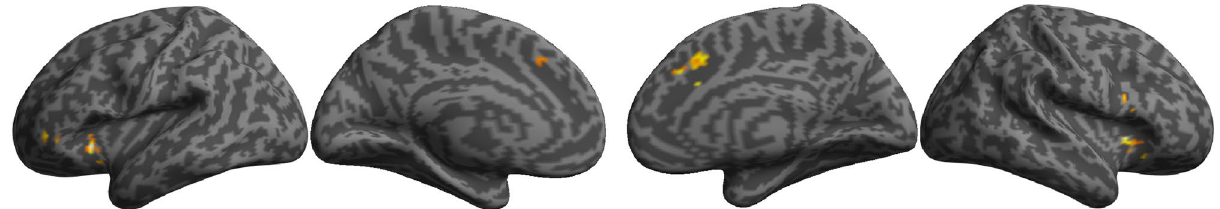
Figure 2. Main effects of matching (congruency effect). The activation revealed by the main effect of matching (congruency effect) in the group analysis was superimposed on a surface-rendered T1-weighted high-resolution MRI of an individual unrelated to the study. The opposite contrast revealed no significant activation. Note that no significant interaction with familiarity was observed. The statistical threshold for the spatial extent test was set at p < 0.05; family-wise error (FWE) corrected for multiple comparisons over the whole brain when the height (cluster-forming) threshold was set at p < 0.001 (uncorrected).